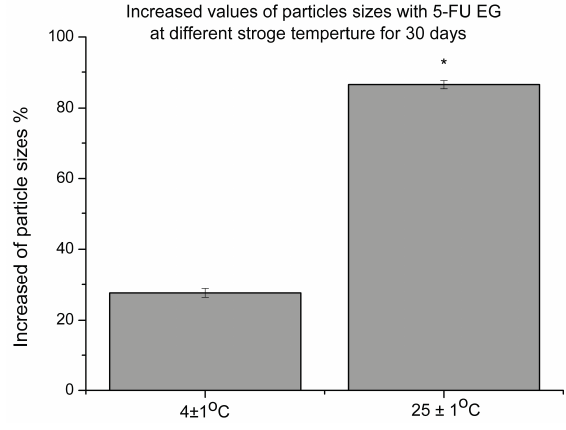
Figure 3. The increased values of particle size with liposomal gel loaded 5-FU at different storage temperatures. Values were expressed as the mean ± SD, using the independent-samples t -test. ( * p < 0.05 compared to 5-FU EGs at 4 ± 1 °C for 30